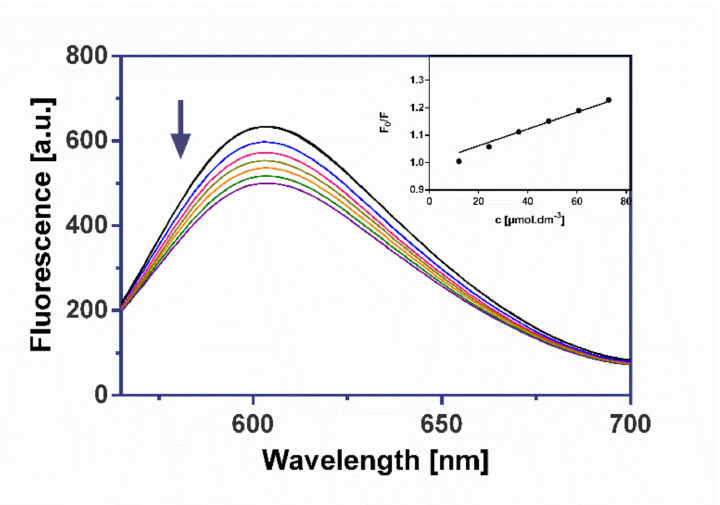
Figure 12. Fluorescence spectrum of DNA–EB complex in the absence (black line) and presence of complex 3 . Inset: the corresponding Stern–Volmer plot for quenching process of EB by 3